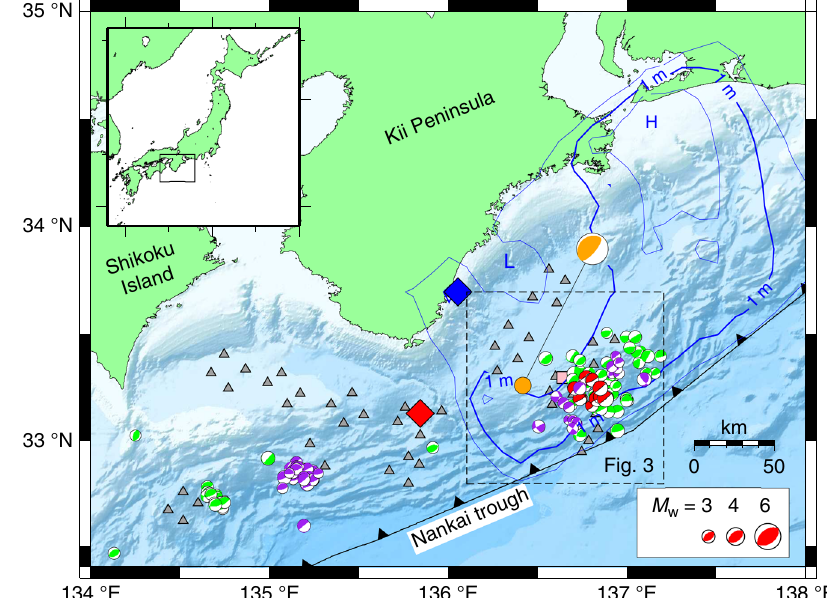
Fig. 1 Locations of the observation network and sVLFEs along the Nankai trough. Gray triangles indicate DONET stations; the pink square near the center of the dashed rectangle is borehole station C0002G. Focal mechanism symbols indicate sVLFEs in 2003 and 2004 34 (green), 2009 9 (red), and 2015 10 (purple). The orange circle with corresponding focal mechanism symbol is the epicenter of the 1 April 2016 off-Mie earthquake ( M JMA 6.5); blue and red diamonds are the epicenters of the 1944 Tonankai and 1946 Nankai earthquakes, respectively. Blue contours represent the slip distribution during the 1944 Tonankai earthquake 43 (contour interval 0.5 m). L and H mark regions of low and high slip,